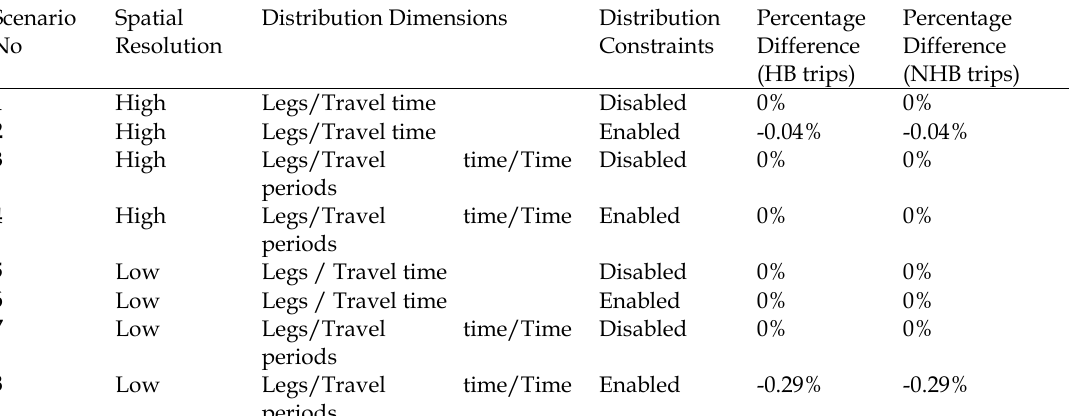
Comparison between the original and the modelled OD total trips’ difference